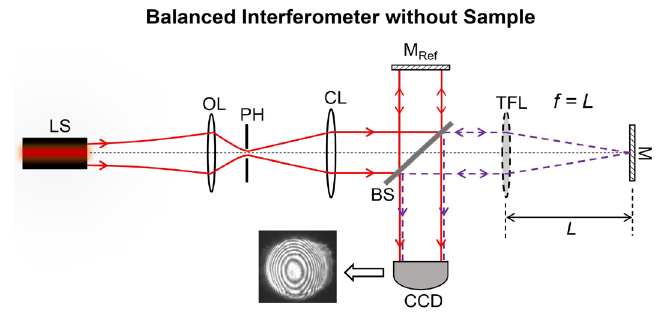
Figure 1. Balanced interferometer without a sample.